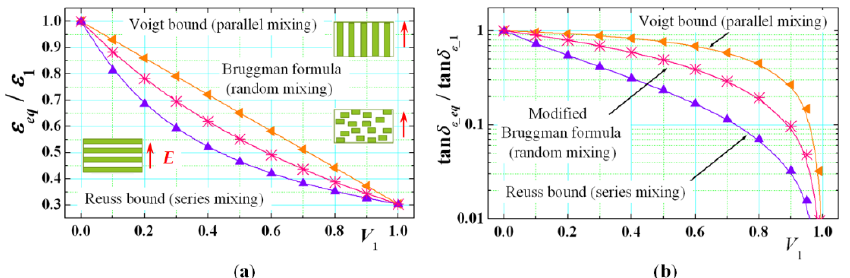
Figure 2. Minimal and maximal bounds for the normalized resultant equivalent dielectric constant ε eq / ε 1 ( a ) and normalized equivalent dielectric loss tangent tan δ ε _eq /tan δ ε _1 ( b ) of two mixed dielectrics with isotropic parameters ε 1 /tan δ ε 1 and ε 2 /tan δ ε 2 and normalized volumes V 1 and V 2 ( V 1 + V 2 = 1) (insets: of parallel, series and random mixing regarding the direction of the applied E field).